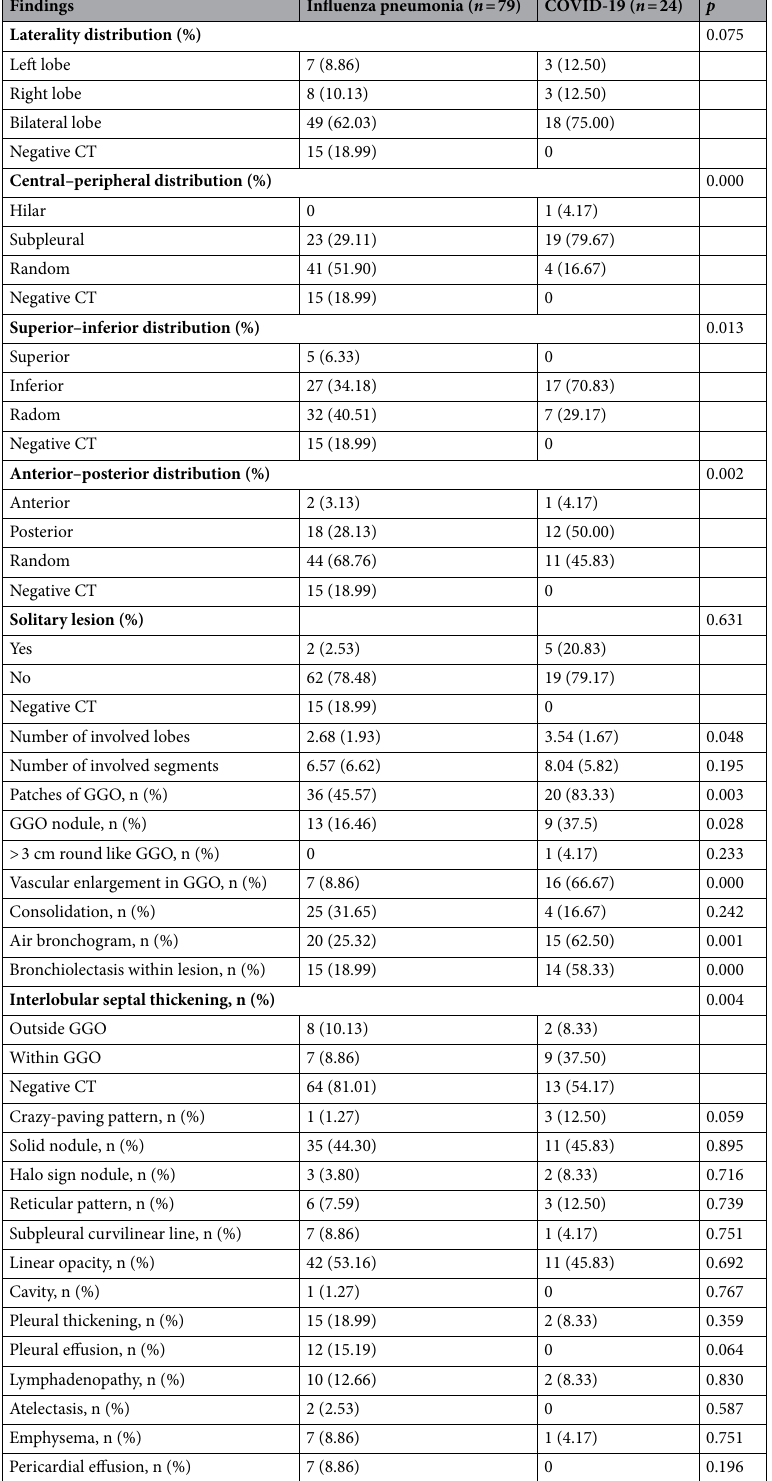
Table 2. Initial chest CT features in 79 patients with influenza pneumonia and 24 with COVID-19. GGO ground-glass